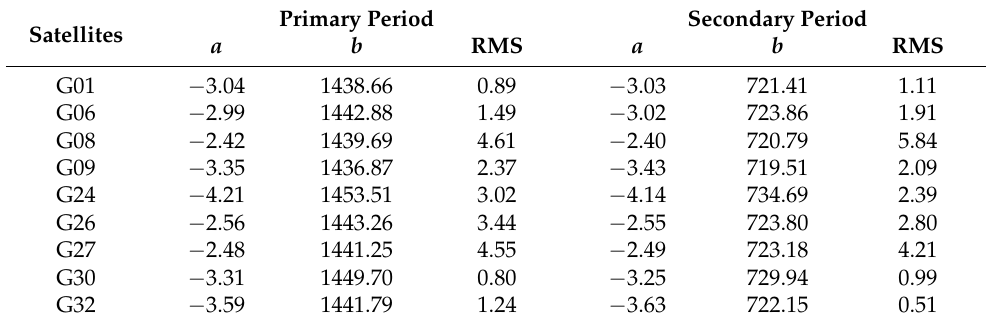
Table 2. The fitting results of the primary period and secondary